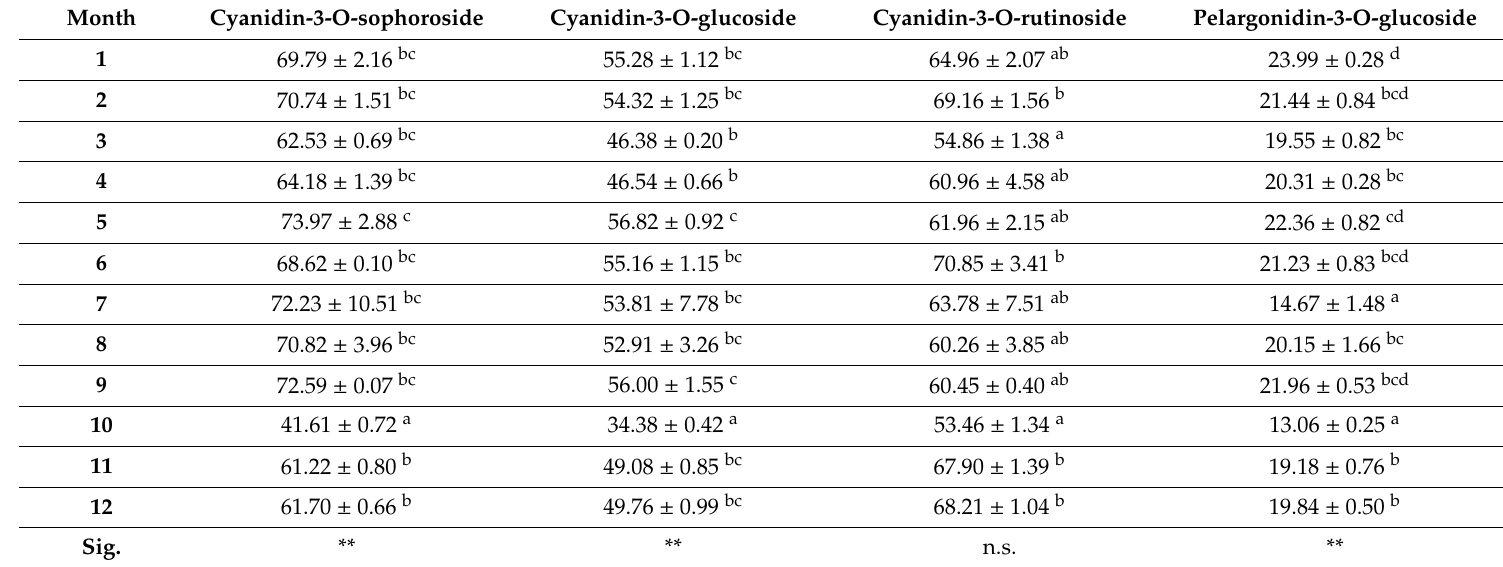
Table 13. Fruits stored at –20 ◦ C in freezer without packaging film. E ff ect of storage period on the di ff erent anthocyanidin compounds content in red raspberries (cv. Erika). Results are expressed in µ g / g of fresh weight. The results are the mean of three replicates ± Standard Deviation. ** ( P ≤ 0.01); n.s. (not significant). The letters represent the significant di ff erence vertically at P ≤ 0.05.